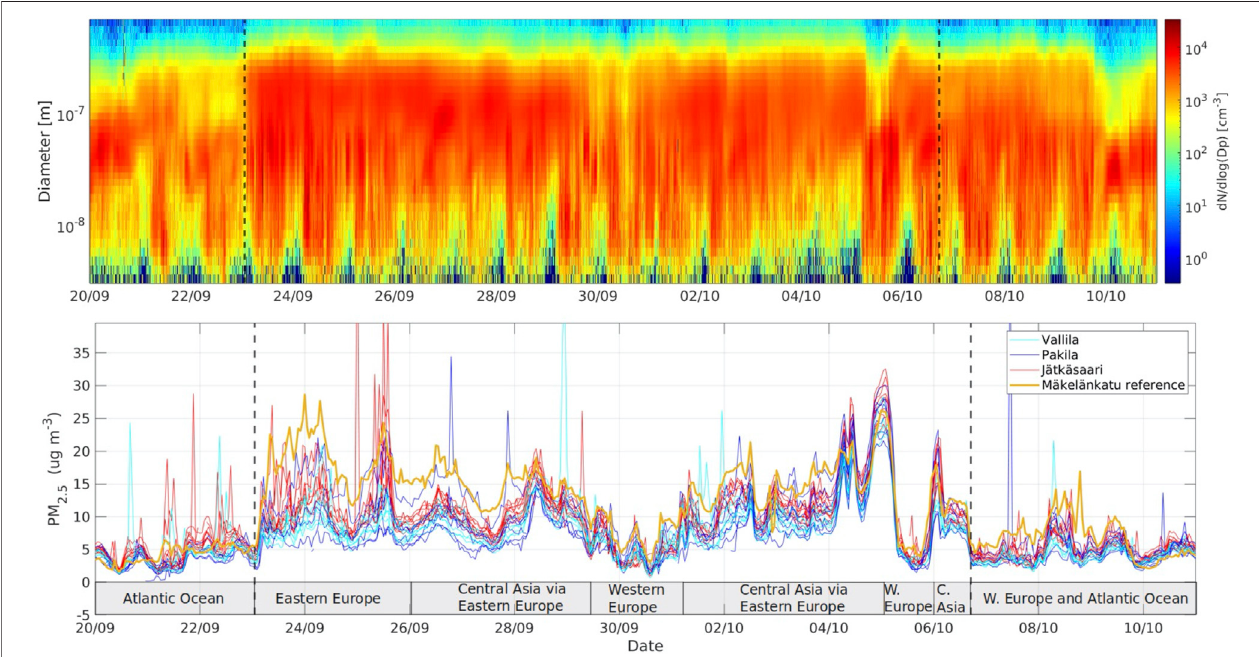
FIGURE 14 | (Top) Aerosol number size distribution measured at SMEAR III station in Helsinki during September 2020. (Bottom) Aerosol mass measurements during September 2020 with a reference instruments and with the sensor network. The air mass backtrajectories indicate that the elevated accumulation mode aerosol particles originate from Eastern Europe. During the long-range transport episodes, aerosol mass concentration is elevated from a typical 5 µg m-3 up to 25 µg m-3 throughout the Helsinki Metropolitan Area. The intermittent lower mass concentrations are concurrent with back trajectories from West Atlantic.